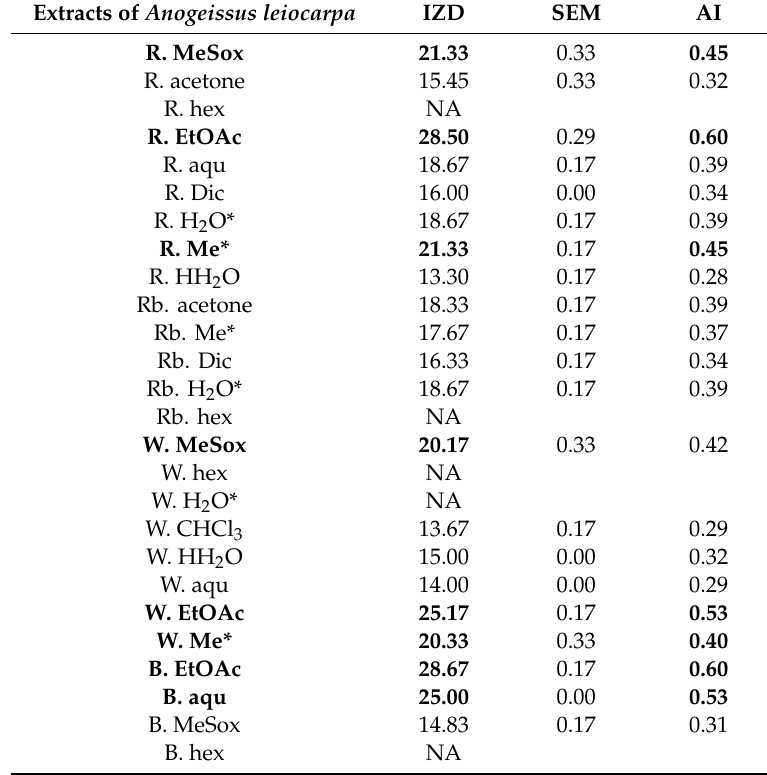
Table 1. In vitro antimycobacterial activity against Mycobacterium smegmatis ATCC 14468 of extracts and fractions of various polarities from Anogeissus leiocarpa roots, stem bark, and leaves. Results obtained with an agar di ff usion method. Activity index (AI) was calculated in relation to rifampicin. Extracts of Anogeissus